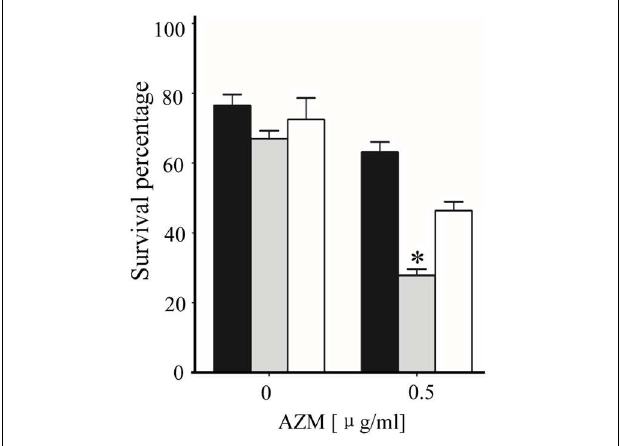
FIGURE 3 | Hydrogen peroxide (H 2 O 2 ) mediated killing of bacteria. PA14, the (cid:49) PA3297 mutant and complemented strain were grown at 37 ◦ C in the absence or presence of 0.5 µ g/ml AZM to an OD 600 of 2.0. Bacteria were collected and washed with PBS. Then the bacteria were incubated in PBS with or without 10% H 2 O 2 for 15 min. The live bacterial numbers were determined by serial dilution and plating. ∗ p < 0.05 compared to PA14 or the complemented strain by student’s t